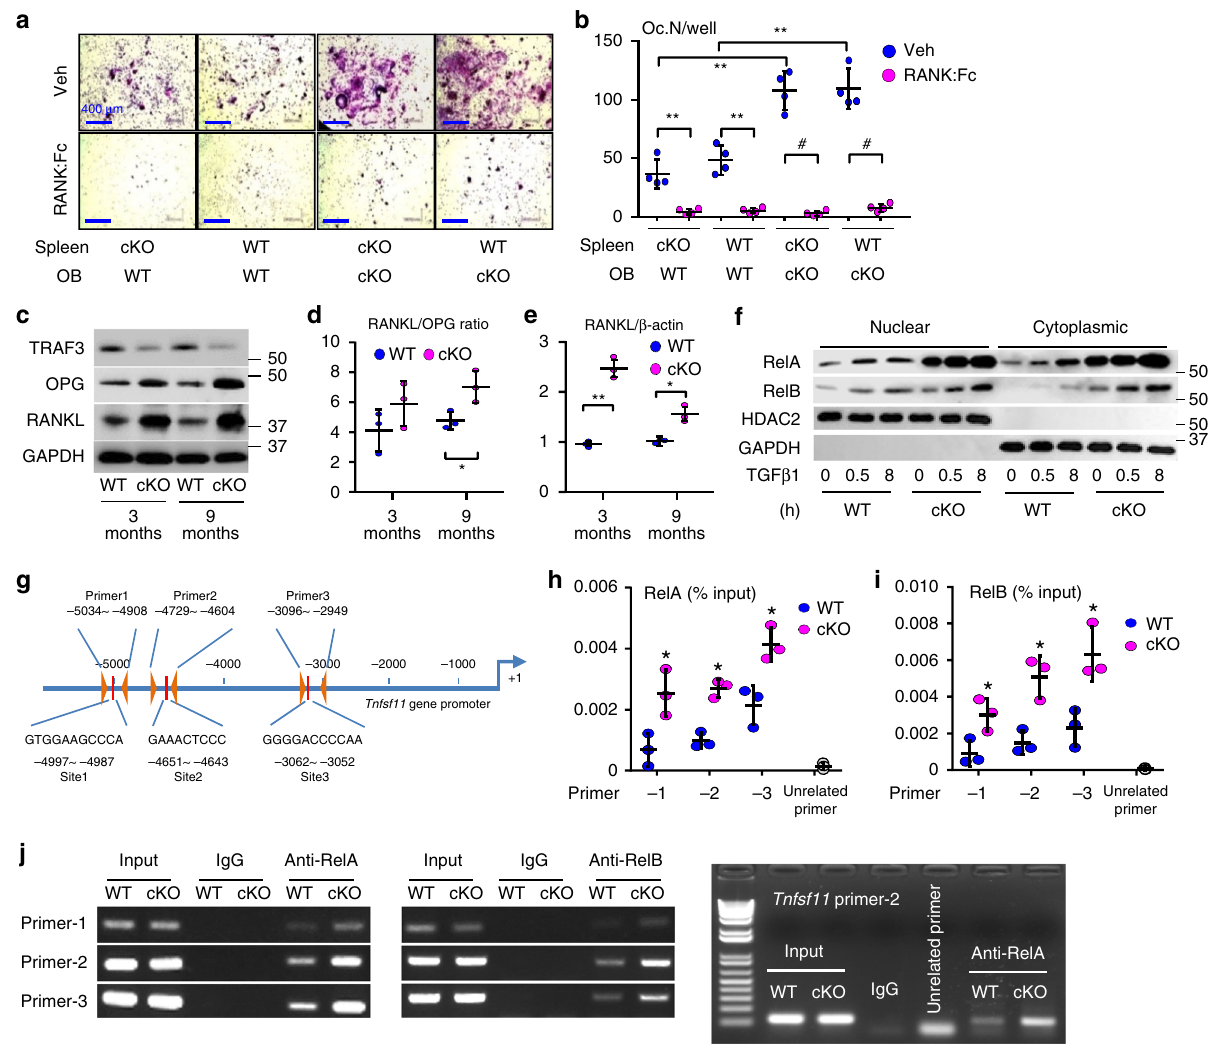
Fig. 5 RANKL expression is increased in TRAF3 cKO osteoblastic cells. a Calvarial pre-OBs and spleen cells isolated from 7-day-old WT or cKO pups, co- cultured with 10 − 8 M 1,25(OH) 2 Vitamin D 3 − / + RANK:Fc (1 µ g/ml) for 7 days and TRAP-stained. b Osteoclast numbers per well (Oc.N/well) in ( a ) were counted. Mean± SD ( n = 4 biologically independent samples; # p < 0.05, ** p < 0.01). c WB of TRAF3, OPG, RANKL, and GAPDH in protein lysates from tibial metaphyseal bone from 3- and 9-m-old WT and cKO mice. d Densitometry analysis of RANKL/OPG protein ratio in ( c ). Mean ± SD ( n = 3 biologically independent samples; * p < 0.05). e RANKL mRNA expression in BdMPCs from 3- and 9-m-old WT and cKO mice. Mean± SD ( n = 3 biologically independent samples; * p < 0.05, ** p < 0.01). f BdMPCs from 3-m-old WT and cKO mice treated with TGF β 1 (1 ng/ml) for 0, 0.5, and 8 h. WB of RelA,